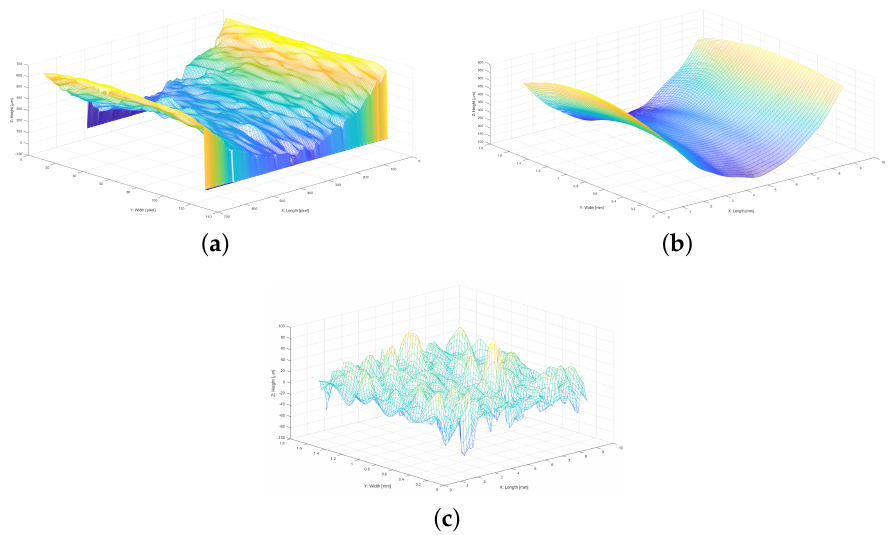
Figure 3. Surface roughness evaluation process. ( a ) Primary surface profile. ( b ) Waviness surface profile. ( c ) Surface roughness profile.